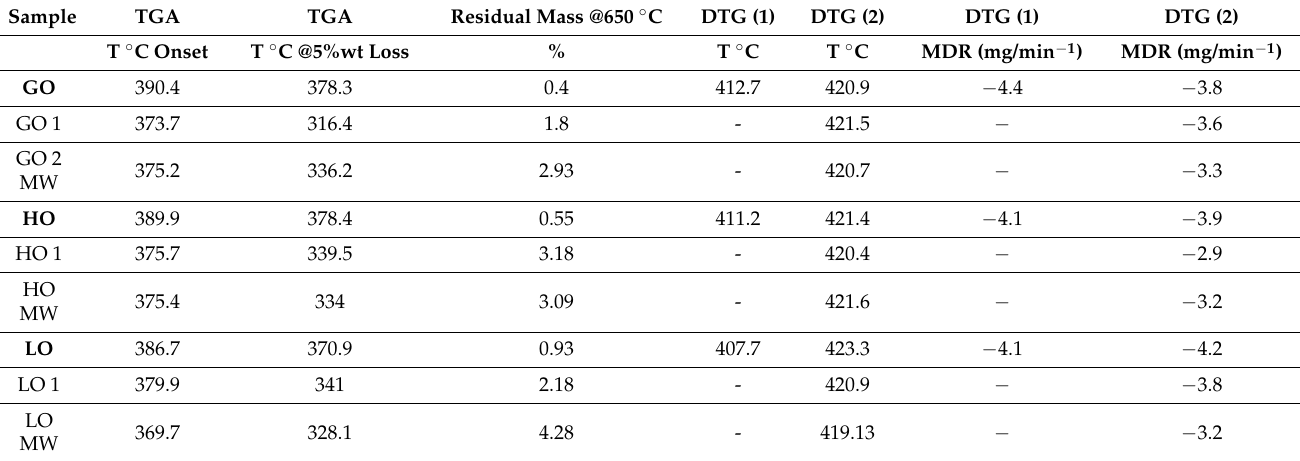
Table 2. TGA under N 2 and DTG data for GO, HO, LO, and related maleinization